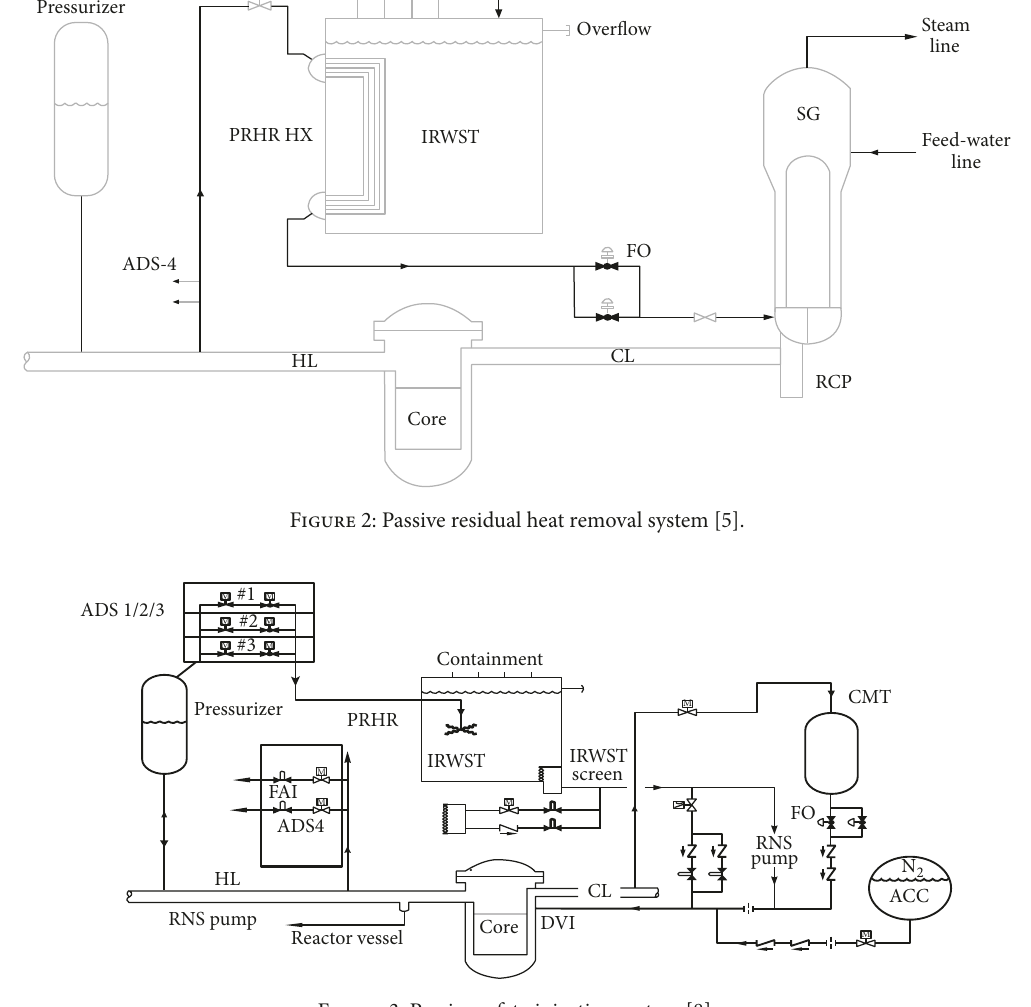
Figure 3: Passive safety injection system